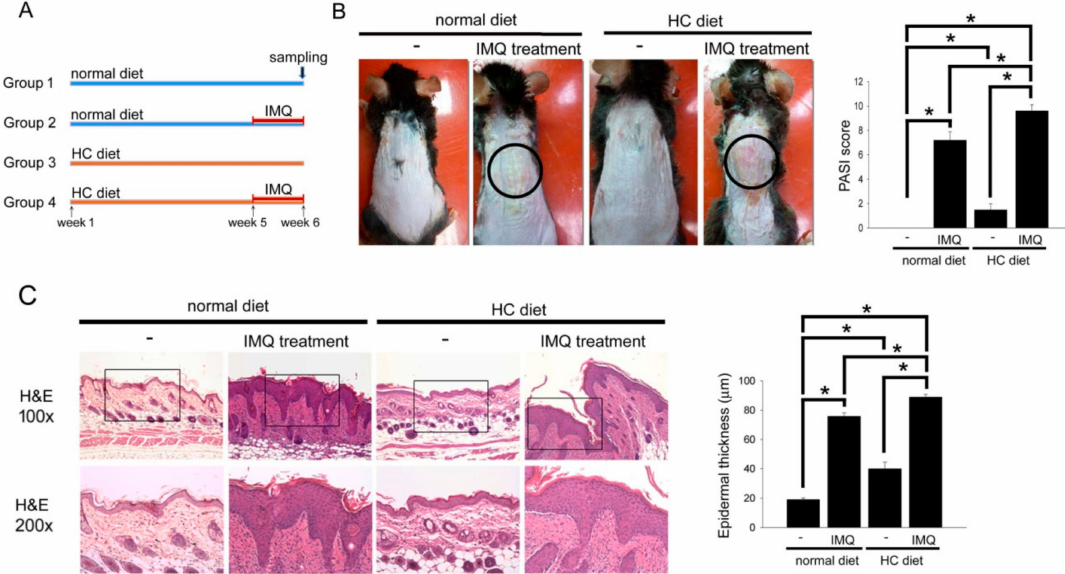
Figure 1. HC-diet aggravated the psoriasis-like phenomena and epidermis hyperplasia in IMQ-treated B6.129S2-Apoe tm1Unc /J mice. ( A ) The progress of the experiment and animal groupings are presented. ( B ) The representative photos of the mice that received IMQ treatment in the normal chow diet or HC-diet groups. The PASI score was demonstrated as a bar graph (right). ( C ) Structural feature characteristics of IMQ-induced psoriasis-like skin were analyzed on H&E stained sections, and analysis using microscopy at 100 × and 200 × magnification of the slide. The epidermis thickness was quantified and presented as a bar graph (right). The results were expressed as the mean ± SD. * p < 0.05 was considered statistically